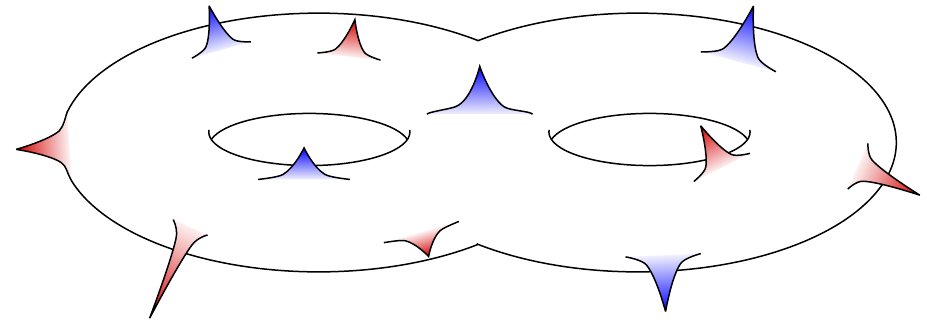
Figure 1 . Regular punctures on the wrapped Riemann surface correspond to conical defects on the Riemann surface in the lower dimensional supergravity. The local information of a puncture is encoded in the opening angle of the corresponding conical defect. The color of the shading surrounding the singularity determines in which transverse direction the puncture